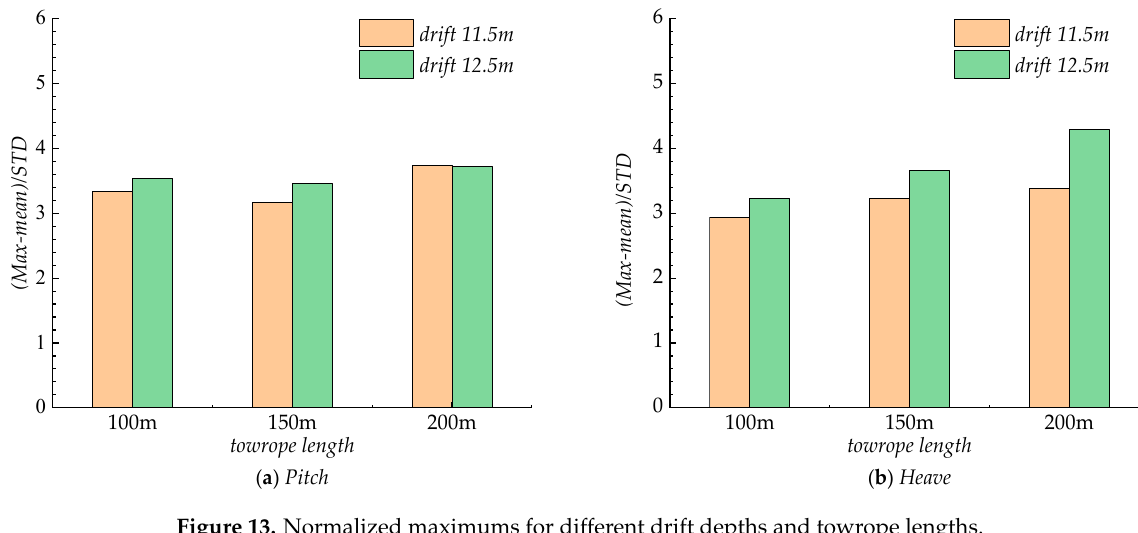
Figure 13. Normalized maximums for different drift depths and towrope lengths.